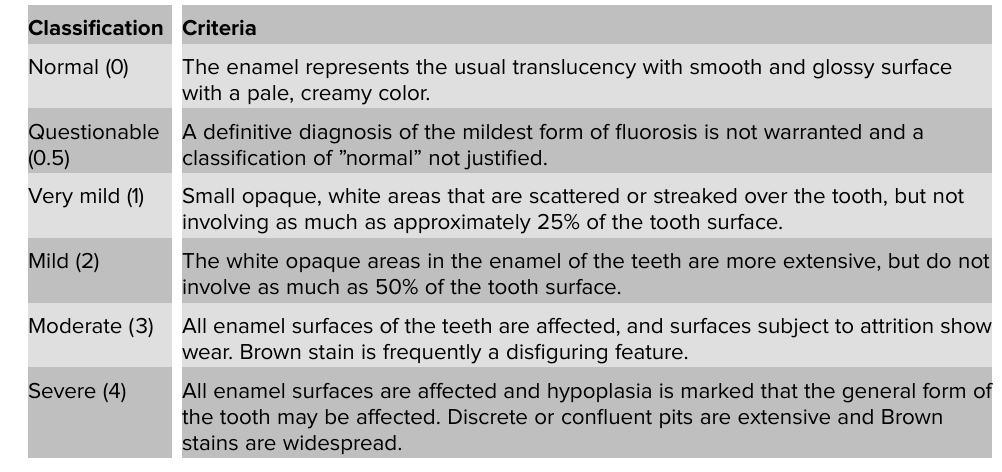
TABLE 1: Dean’s Index for dental fluorosis